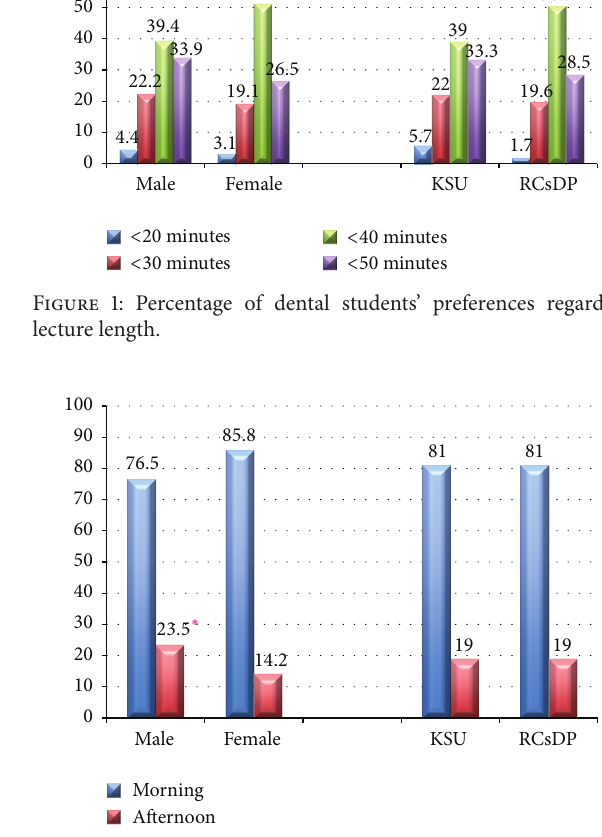
Figure 2: Percentage of dental students’ preferences regarding lecture timing ( ∗ 𝑃 < 0.05